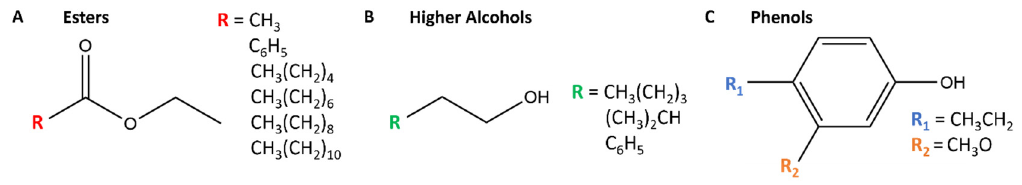
Figure 1. Volatile organic species of interest to this study include esters ( A ), higher alcohols ( B ), and phenols ( C ) with specific functional groups color coded above. Esters ( A ) that are routinely observed herein include ethyl acetate (R = CH 3 ), ethyl benzoate (R = C 6 H 5 ), ethyl hexanoate (R = CH 3 (CH 2 ) 4 ), ethyl octanoate (R = CH 3 (CH 2 ) 6 ), ethyl decanoate (R = CH 3 (CH 2 ) 8 ), and ethyl dodecanoate (R = CH 3 (CH 2 ) 10 ). Higher alcohols ( B ) of importance to cider aroma include 1-hexanol (R = CH 3 (CH 2 ) 3 ), 3-methyl-1-butanol (R = (CH 3 ) 2 CH), and 2-phenylethyl alcohol (C 6 H 5 ). Lastly, volatile phenols that are considered defect odors in cider include 4-ethylphenol (R 1 = CH 3 CH 2 ) and 4-ethyl-2-methoxyphenol (R 1 = CH 3 CH 2 and R 2 = CH 3 O).